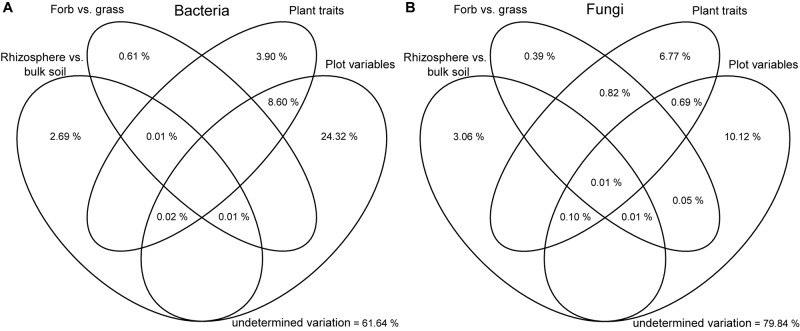
Variation partitioning analysis, illustrating the effects of soil compartment, plant functional group, plant traits and plot variables on the community structure of bacteria (A) and fungi (B). Each ellipse represents the portion of variation accounted by each factor. Shared variance is represented by the intersecting portions of the ellipses. Values ≤ 0 are not shown.